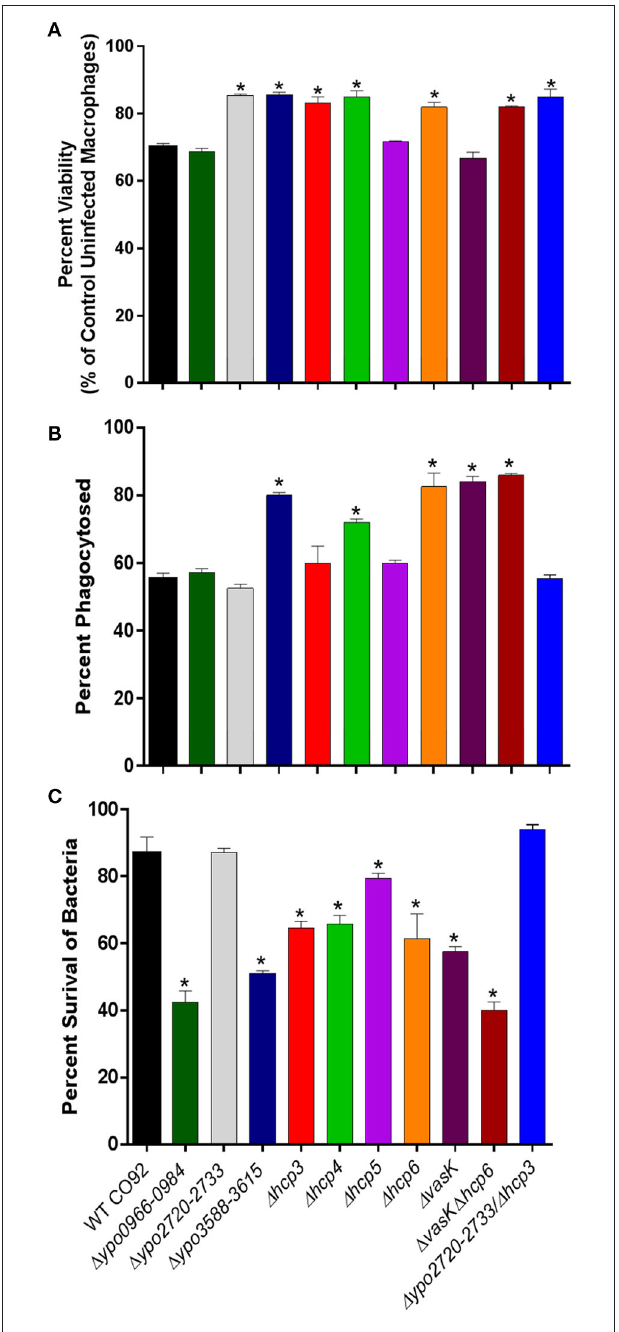
FIGURE 6 | Possible mechanisms of attenuation of Y. pestis CO92 mutants . (A) Determination of bacterial cytotoxicity to murine macrophages. RAW264.7 murine macrophages were infected with the indicated Y. pestis strains at an MOI of 100 for 1h, washed with PBS, treated with gentamicin (50 µ g/ml) for 1h, then washed with PBS and incubated with a maintenance dose of gentamicin (10 µ g/ml) in DMEM for 12h. Viability following infection was then evaluated by the MTT assay. The data were plotted as mean percentages of uninfected macrophages, pooled from two independent experiments, with four replicates per experiment, and were analyzed by one-way ANOVA with Tukey’s post-hoc test. * P < 0.05. (B) Percent phagocytosis of Y. pestis strains in